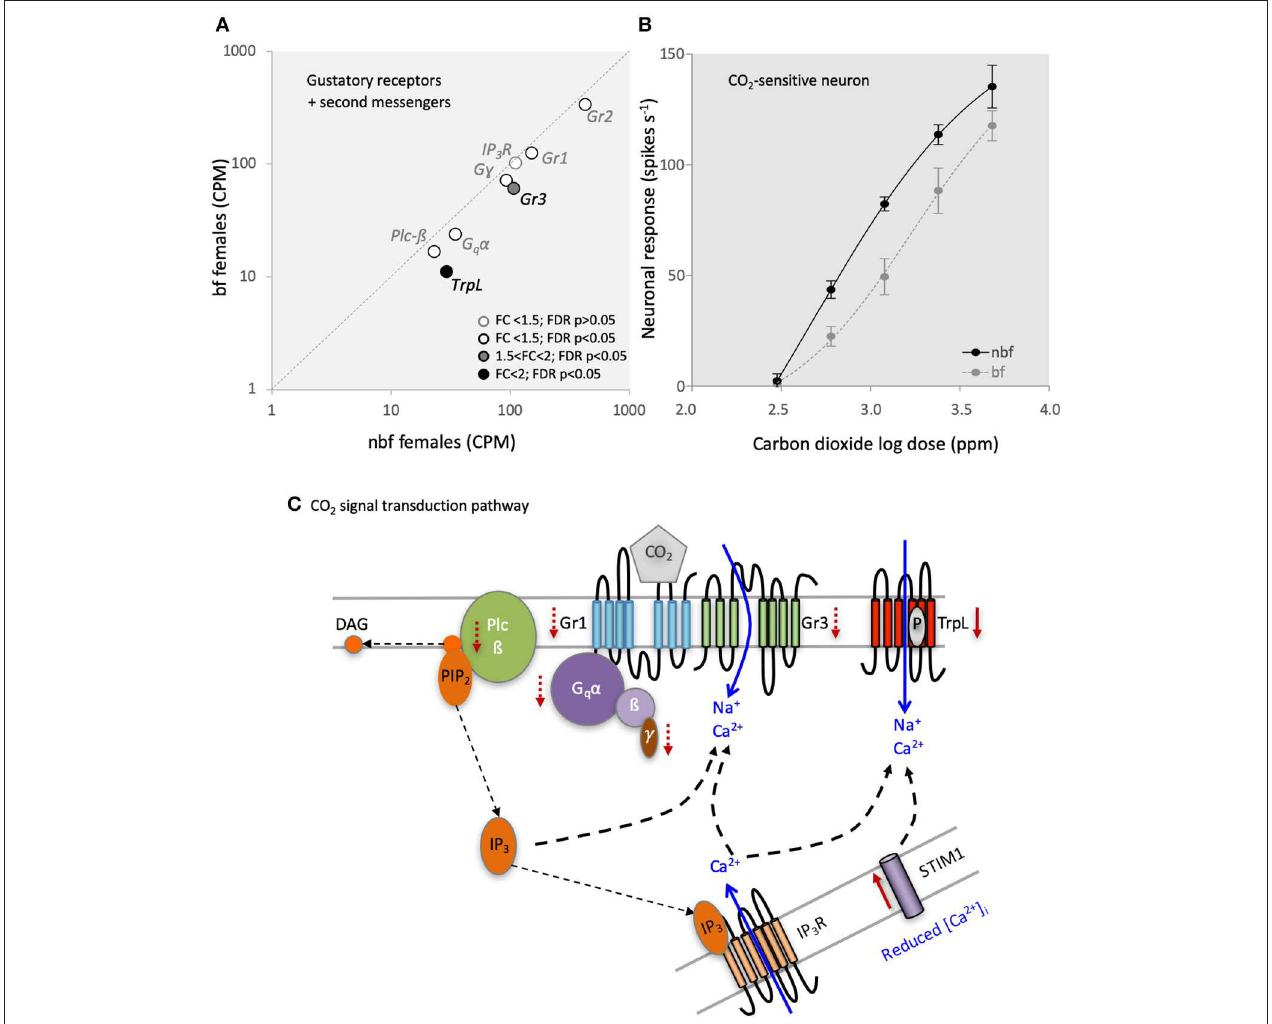
FIGURE 3 | Carbon dioxide (CO 2 ) signaling in the maxillary palps. (A) Differential transcript regulation of CO 2 -sensitive gustatory receptors ( Gr1 and Gr3 ), Gr2 and the second messenger genes, phospholipase c beta ( Plc-ß ), G q -protein alpha subunit ( G q α ), G-protein gamma subunit ( G γ ), and inositol trisphosphate receptor ( IP 3 R ) in the maxillary palps of blood fed (bf) and non-blood fed (nbf) Aedes aegypti females is shown. Transcripts that exhibit significant differences in abundance (Kal’s test; FDR P < 0.05), are denoted according to their fold change (FC); FC > 2 in black-filled circles; 1.5 < FC < 2 in gray-filled circles; and FC < 1.5 in unfilled circles. (B) Differential response of the CO 2 -sensitive neuron to various concentrations of CO 2 is shown. (C) Model of the putative CO 2 signaling pathway. Solid red arrows indicate significant (FC > 2; FDR P > 0.05) and dashed red arrows indicate potential (FC < 2; FDR P > 0.05) changes in regulation. Diacylglycerol (DAG); phosphatidylinositol 4,5-bisphosphate (PIP2); G-protein beta subunit (ß); G-protein gamma subunit ( γ ); Stromal interaction molecule 1 (STIM1); transient receptor potential receptor L